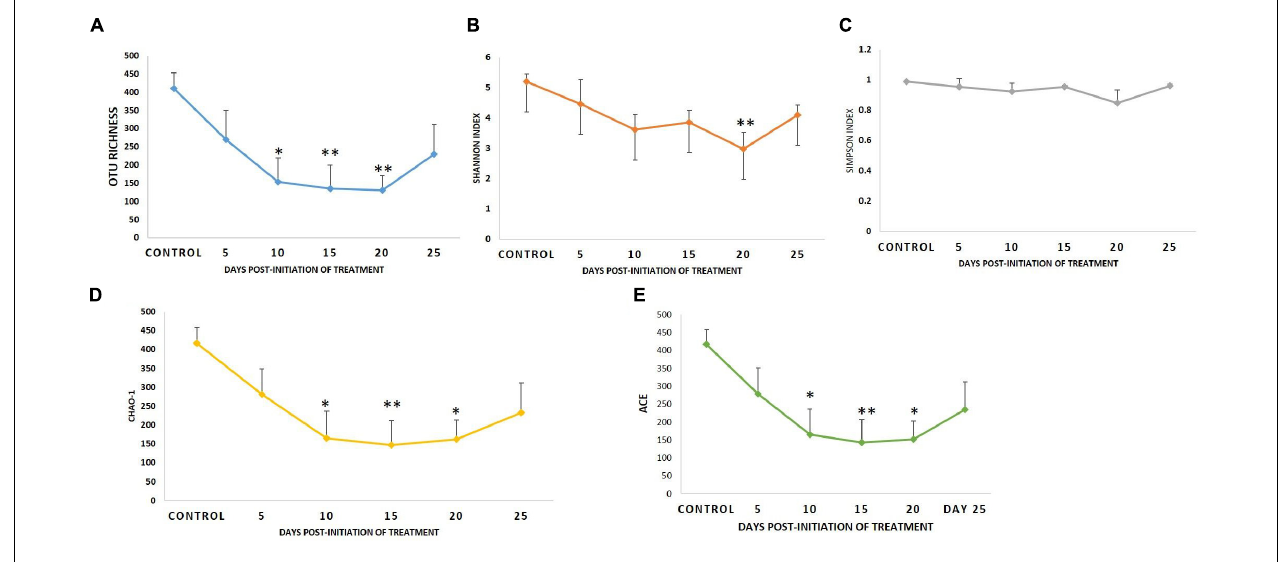
FIGURE 4 | Dynamics of microbial diversity measures following therapeutic exposure of FFC. (A) Dynamics of OTU richness. (B) Dynamics of Shannon index. (C) Dynamics of Simpson index. (D) Dynamics of Chao-1. (E) Dynamics of abundance-based coverage estimator. P -values less than 0.05, 0.01, and 0.001 are summarized with one, two, and three asterisks, respectively, to represent the significant difference levels from the control animals.